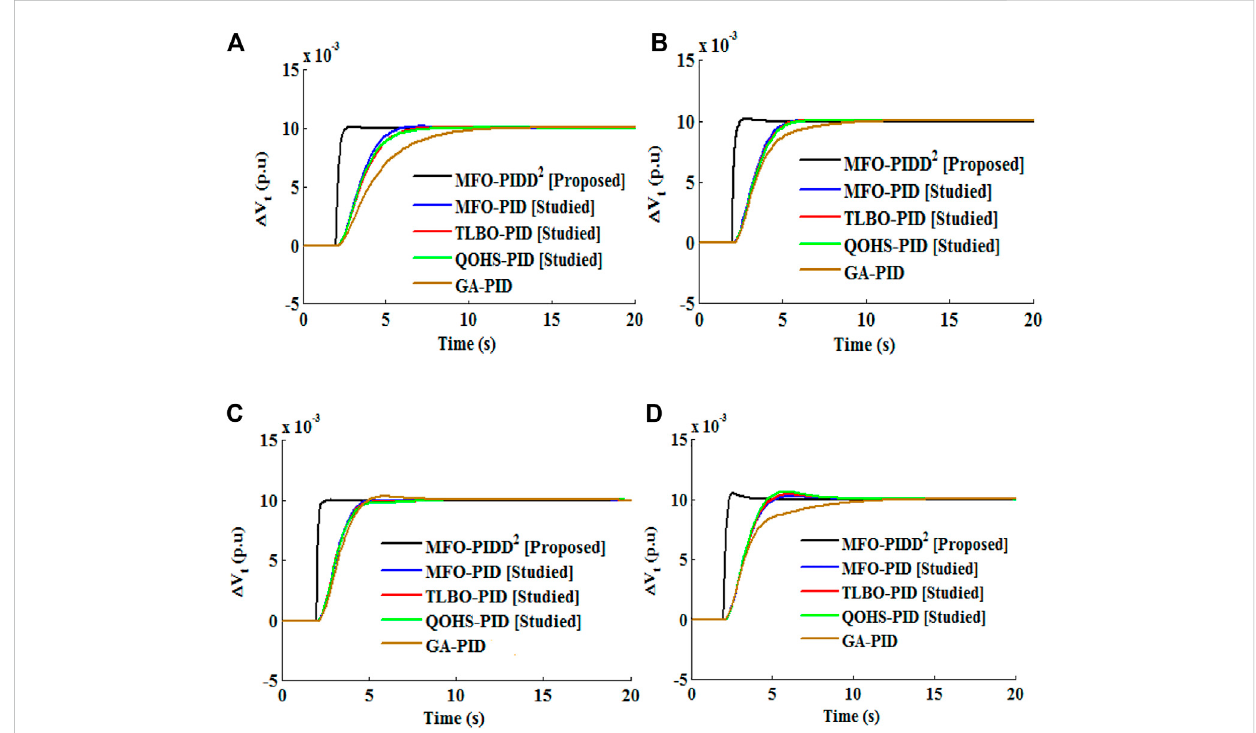
FIGURE 5 Comparison oftransientcharacteristicsfor (A) K G (cid:2) 0 . 7; τ G (cid:2) 1 . 2 s, (B) K G (cid:2) 0 . 8and τ G (cid:2) 1 . 2 s, (C) K G (cid:2) 0 . 9; τ G (cid:2) 1 . 0 sand (D) K G (cid:2) 1 . 0and τ G (cid:2) 1 . 6